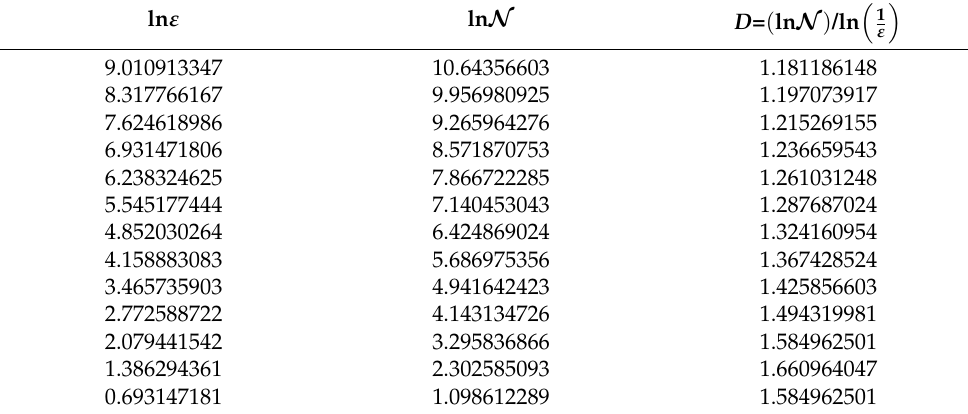
Table 4. Values of ln ε , ln N , and D for each n .